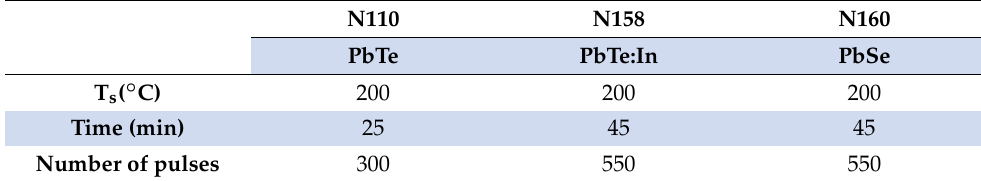
Table 3. Layer growth parameters deposited on the Al 2 O 3 substrate for electrical measurements.